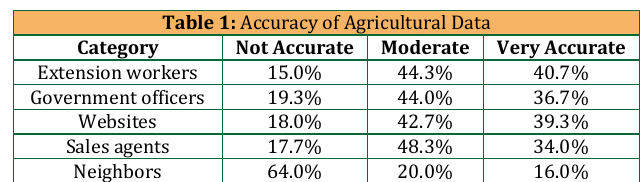
Figure 2: Preferred format for Information Dissemination